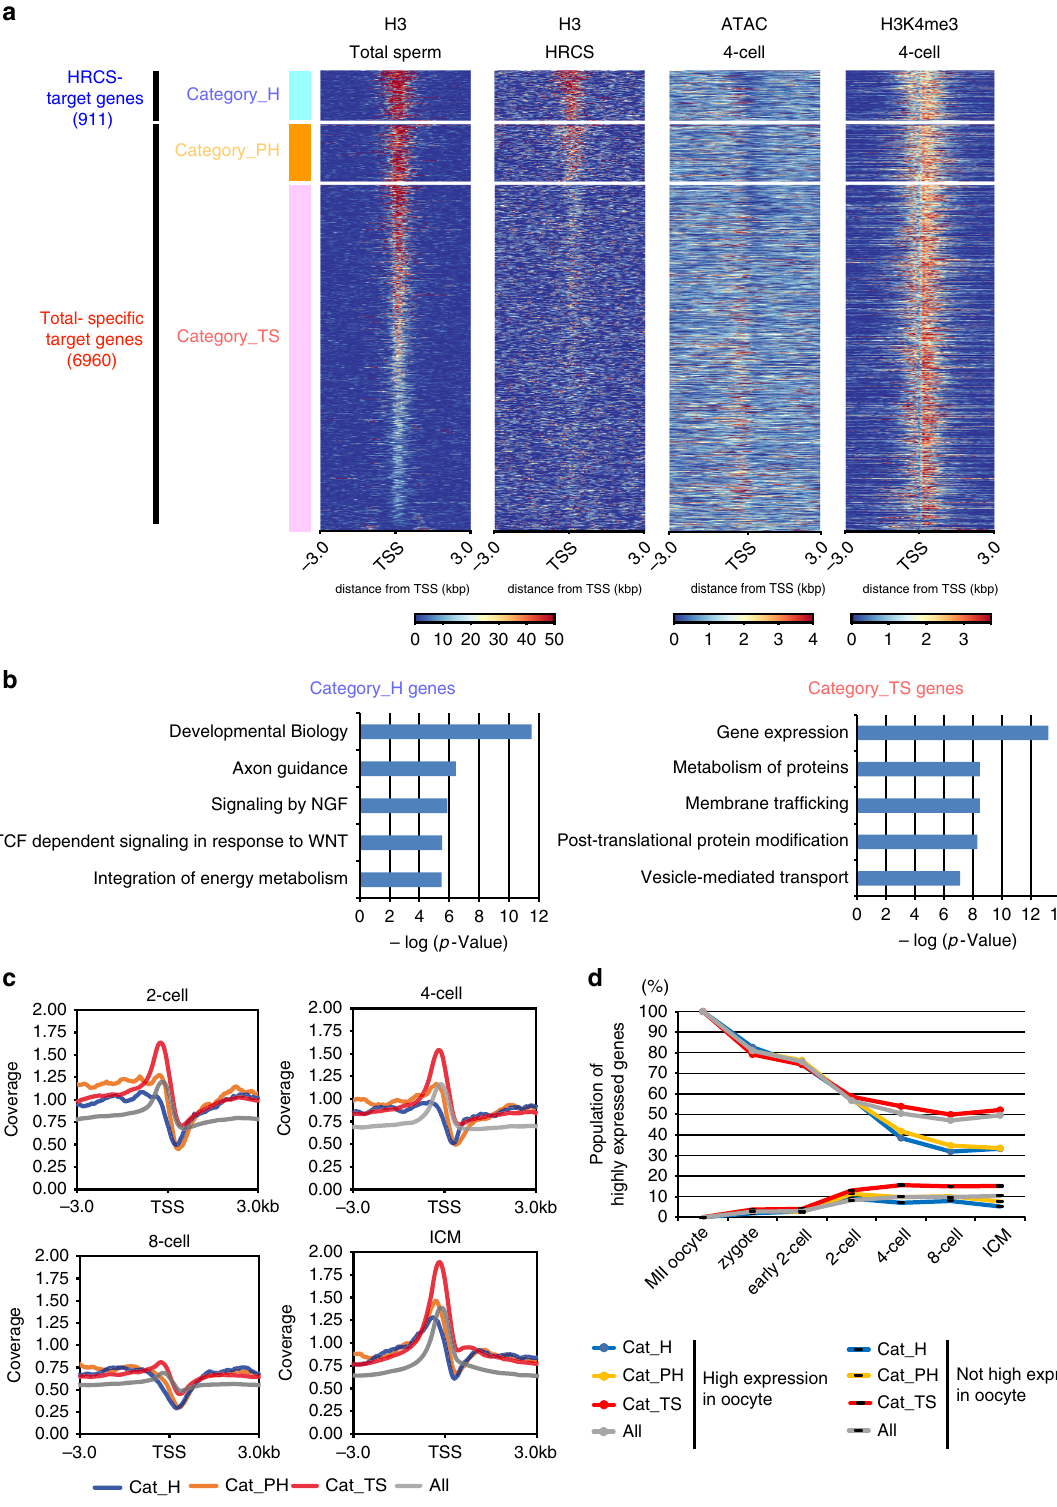
Supplementary Fig. 9). The pro fi le plot of ATAC-seq signal also showed a sharp drop around the TSS of category_H/PH from the two-cell to eight-cell stage, but a clear peak around the TSS of category_TS and all genes from the two-cell to four-cell stage (Fig.